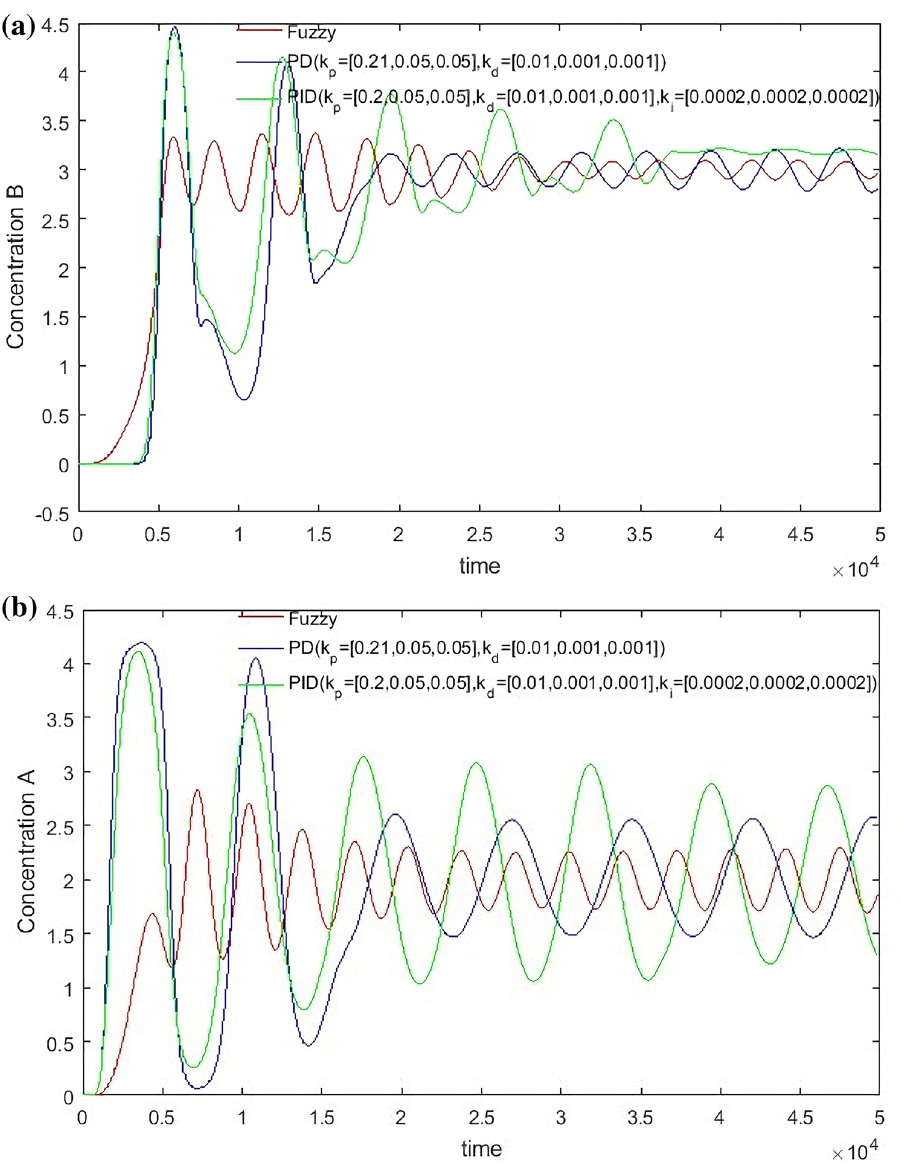
Figure 16. Desired B = 3, desired A = 2, Switch time = 180